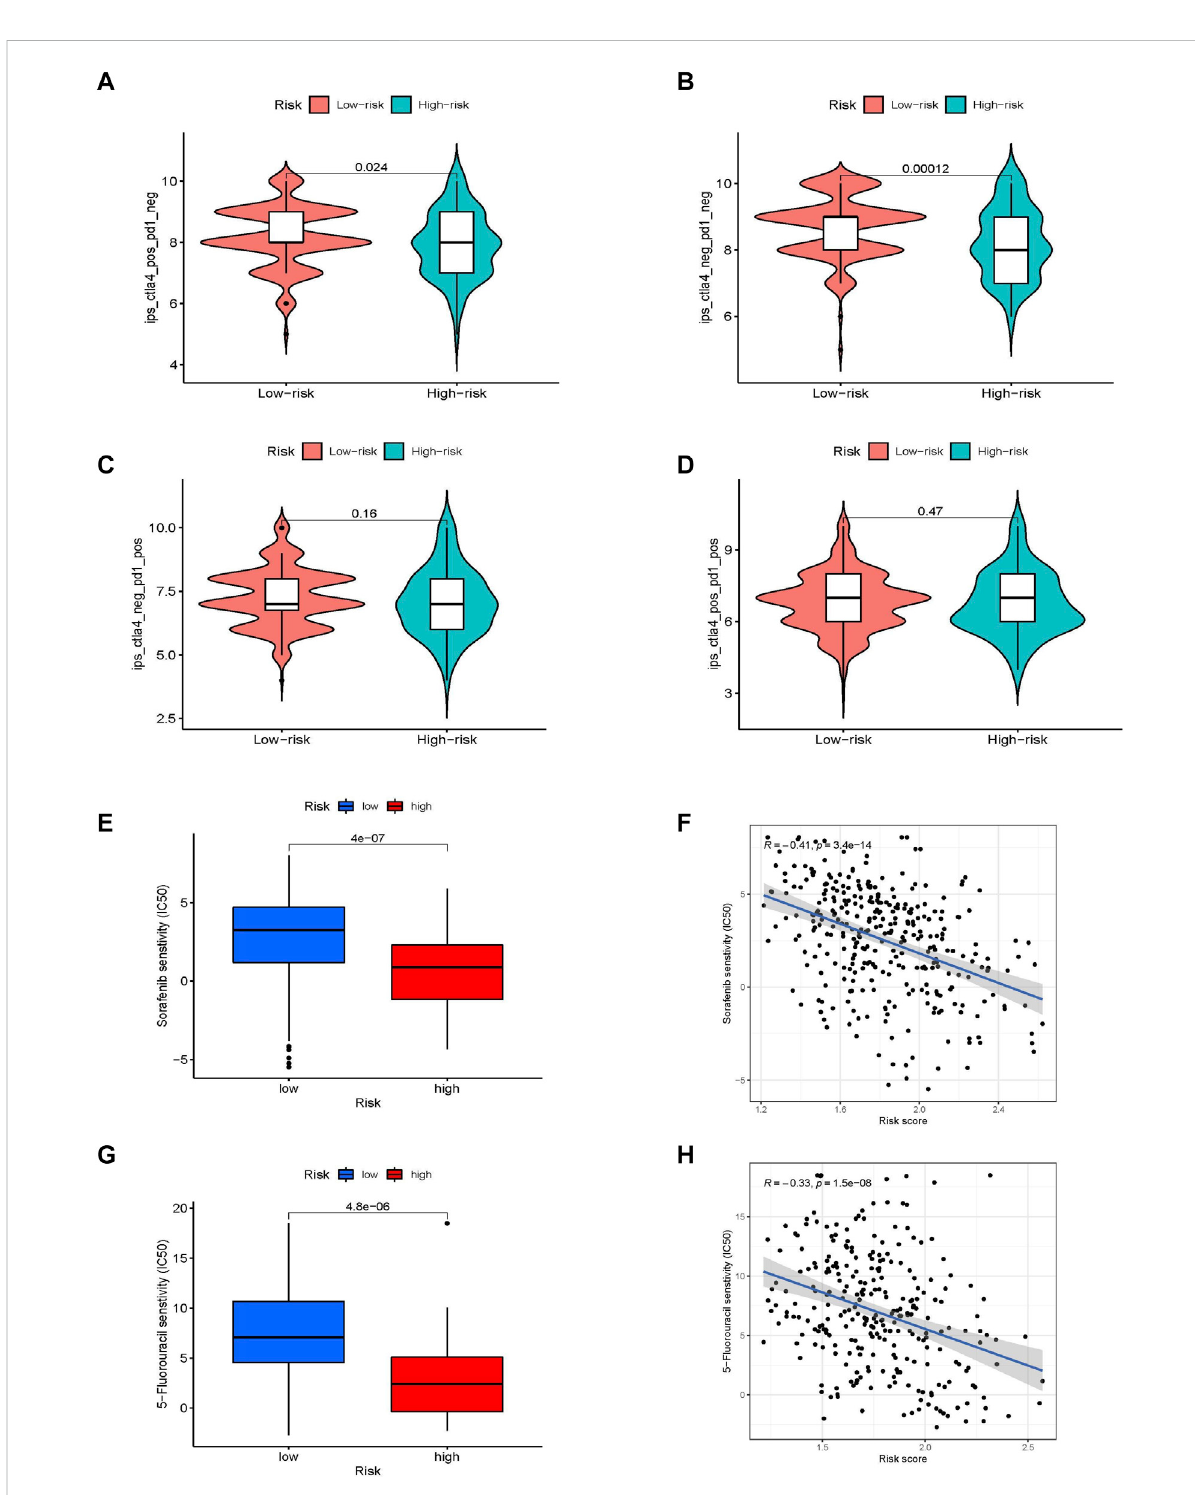
FIGURE 6 The value of different glycometabolism-related risk scores for ICI treatment and drug sensitivity. (A – D) Comparison of the responsiveness to anti-PD-1 and anti-CTLA-4 immunotherapy between samples in high-risk and low-risk groups. (E – H) Comparison of the sensitivities and associations to sorafenib and 5- fl uorouracil drugs between high-risk and low-risk groups.